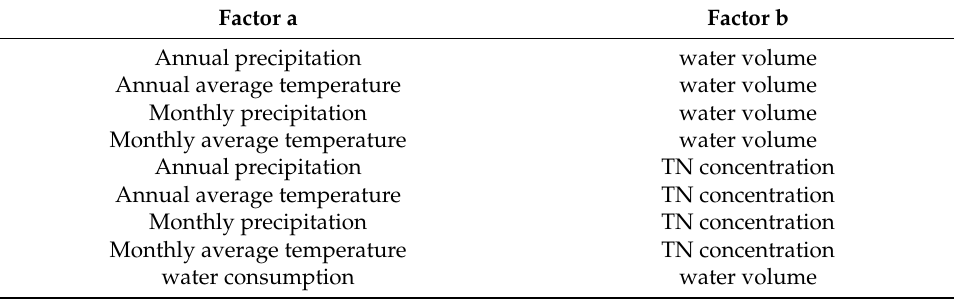
Table 2. Correlation analysis